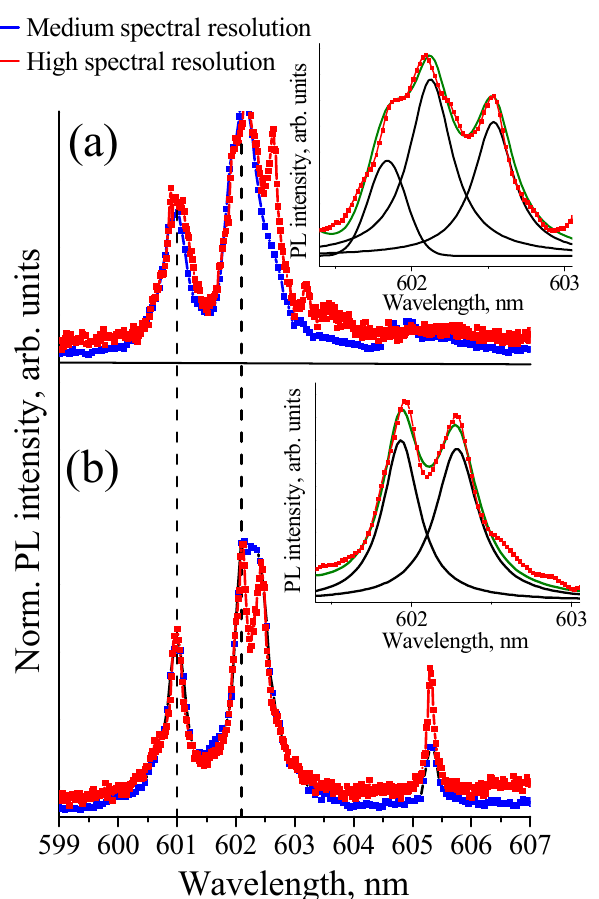
Figure 4. The ZPL spectra of the ensembles of GeV − color centers. The spectra of two different nanodiamonds shown in ( a , b ) were recorded with medium (0.07 nm) and high spectral resolution (0.03 nm) at T = 80 K. Inset: Deconvolution of the broad line of the ZPL doublet with the maximum at ~602.1 nm. The vertical lines show the spectral positions of the ZPL doublet of GeV − centers for microcrystal diamond with high crystalline quality at T = 77 K [12].